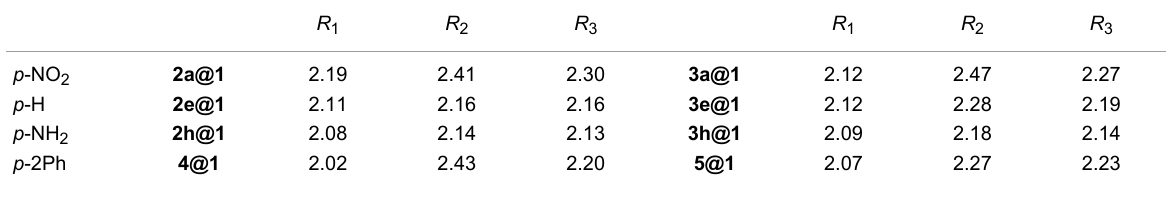
Table 5: Hydrogen bond geometry in Å for the different pseudorotaxane systems with solvent model, labeling see Figure 2. The second and third last lines show the substitution at the meta-position.